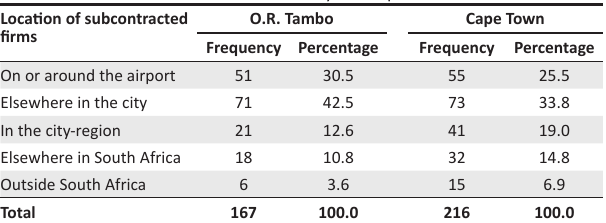
TABLE 5: Location of firms subcontracted by the airport-centric firms. Location of subcontracted firms